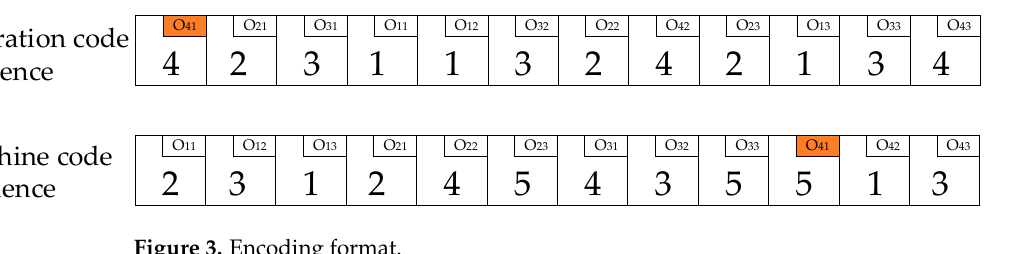
Figure 3. Encoding format.